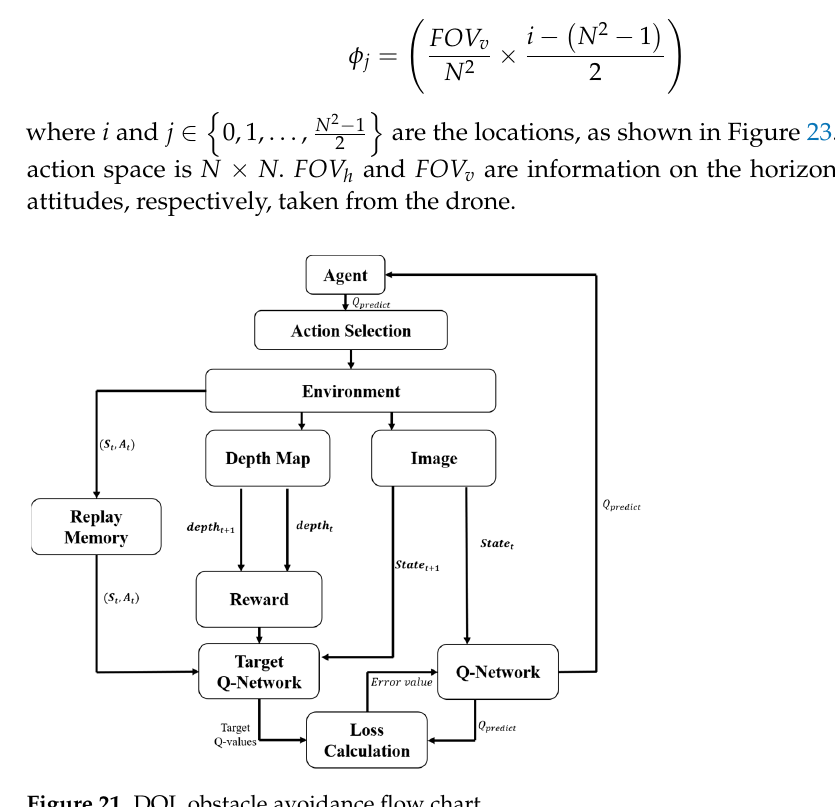
Figure 21. DQL obstacle avoidance flow chart.